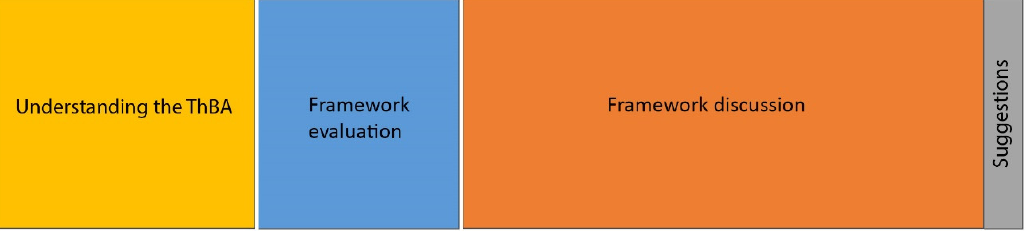
Figure 5. Proportional representation of all references coded for the main themes.